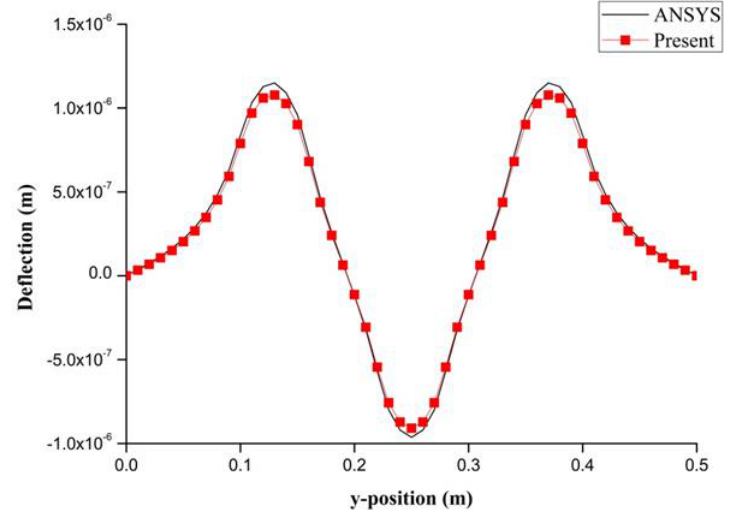
Figure 17. Deflection along the horizontal line ( y = 0.25 m) of the composite laminate plate induced by distributed PZT actuators. Materials 2020 , 13 , x FOR PEER REVIEW